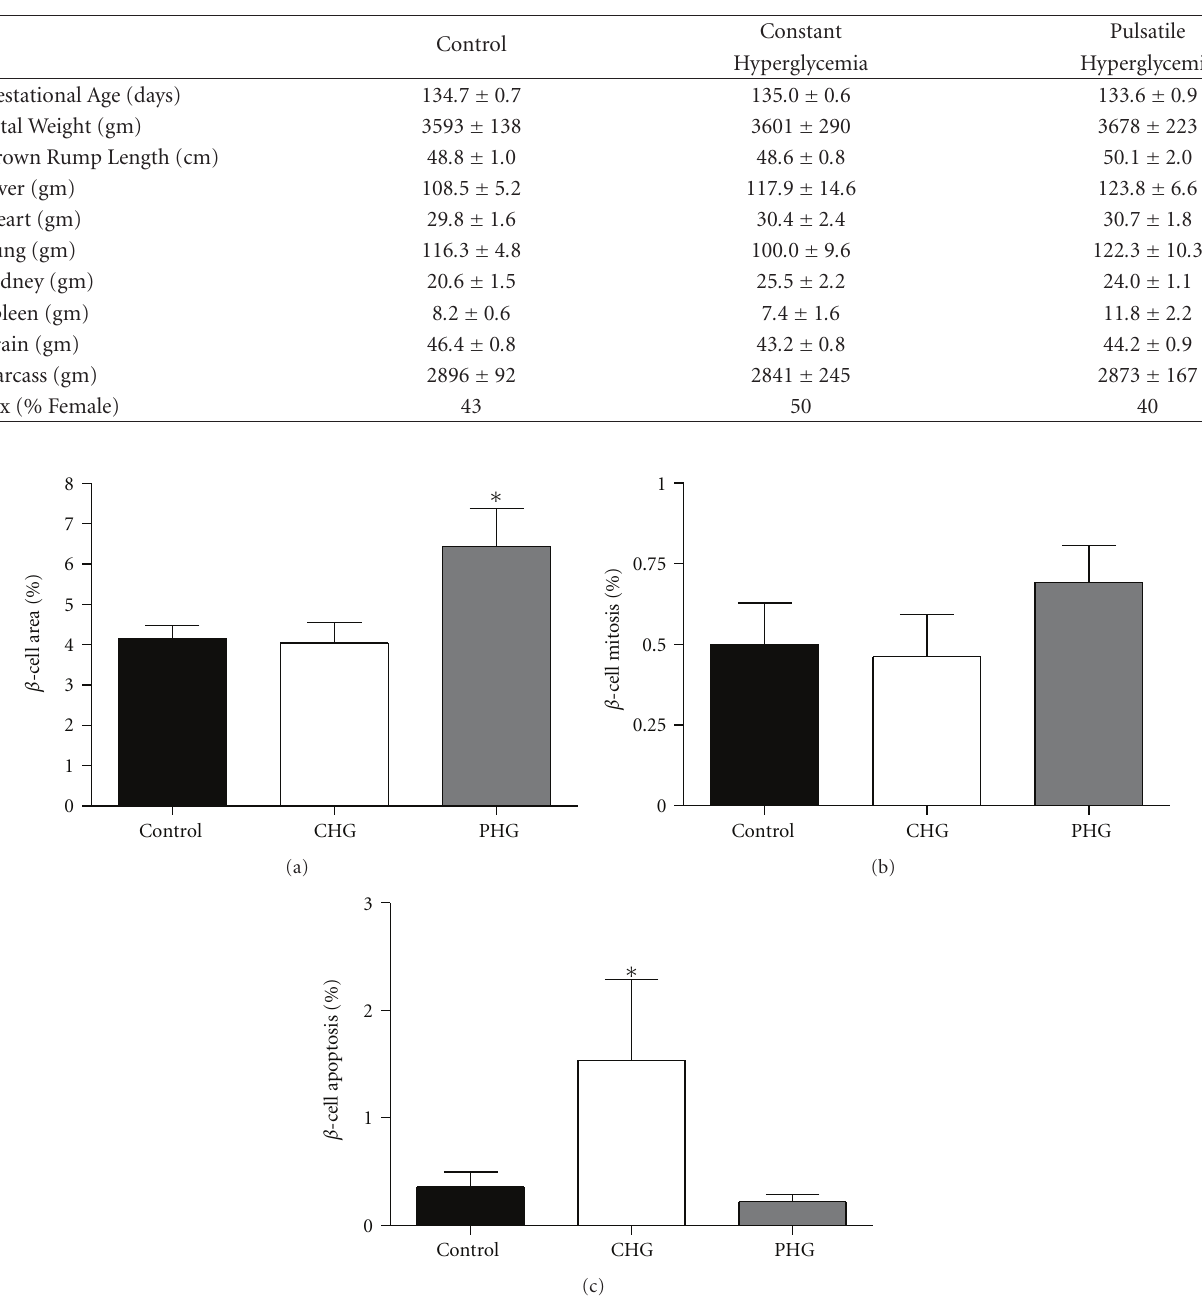
Figure 3: Fetal pancreatic β -cell area, mitosis, and apoptosis. Fetal pancreatic β -cell area (a), mitosis (b), and apoptosis (c) were measured in control ( n = 7, black bars), CHG ( n = 6, white bars), and PHG ( n = 5, gray bars) fetal pancreases. ∗ indicates a significant di ff erence, P = 0 .